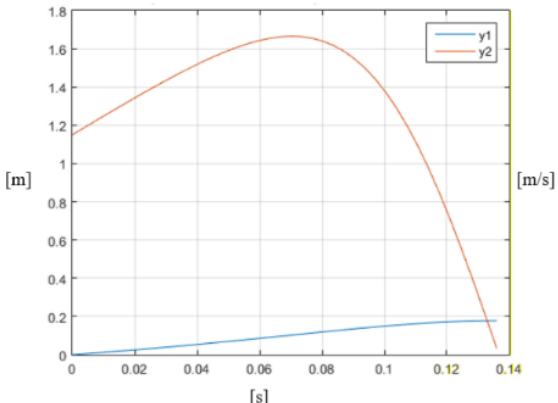
Figure 13. Displacement (blue line) and velocity of the buffer (orange line) at an operating temperature of −60 °C, an impact speed of v 0 = 1.15 m/s, and 𝜂 𝐶𝑇 = 0.7 .